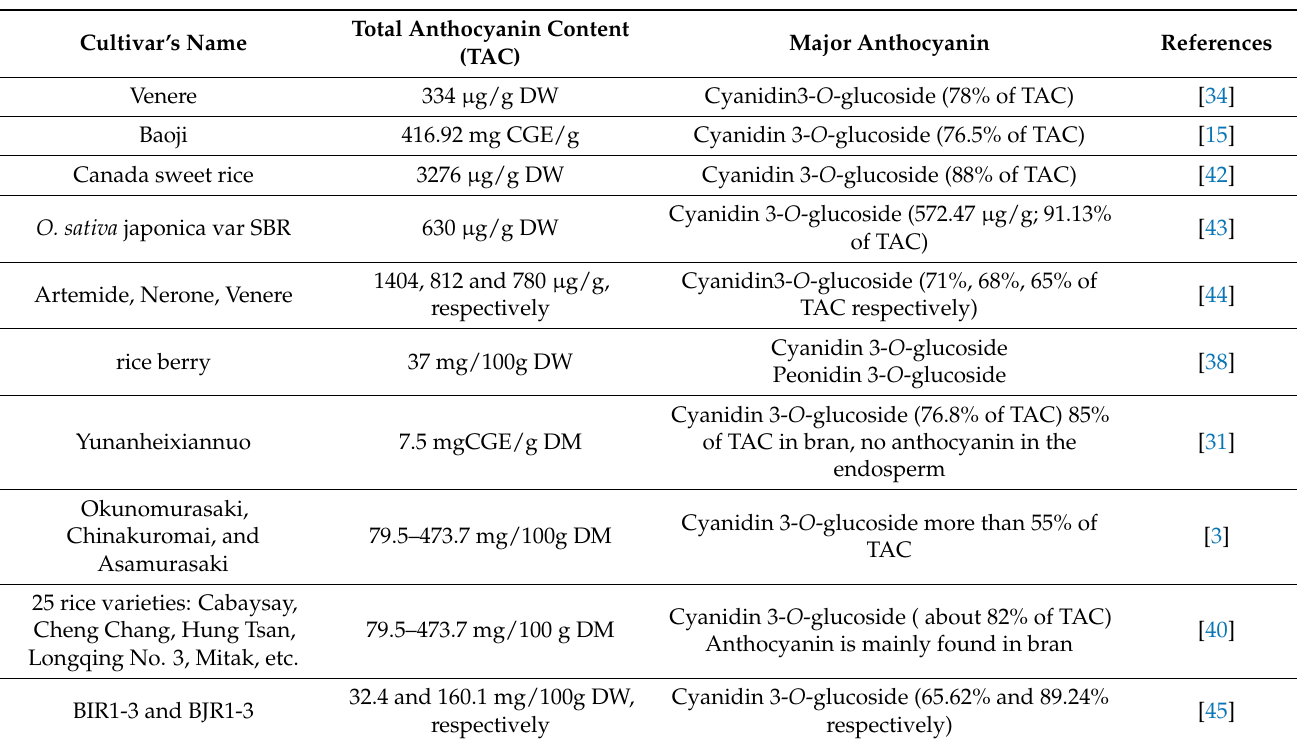
Table 3. Quantification of anthocyanin in different black rice